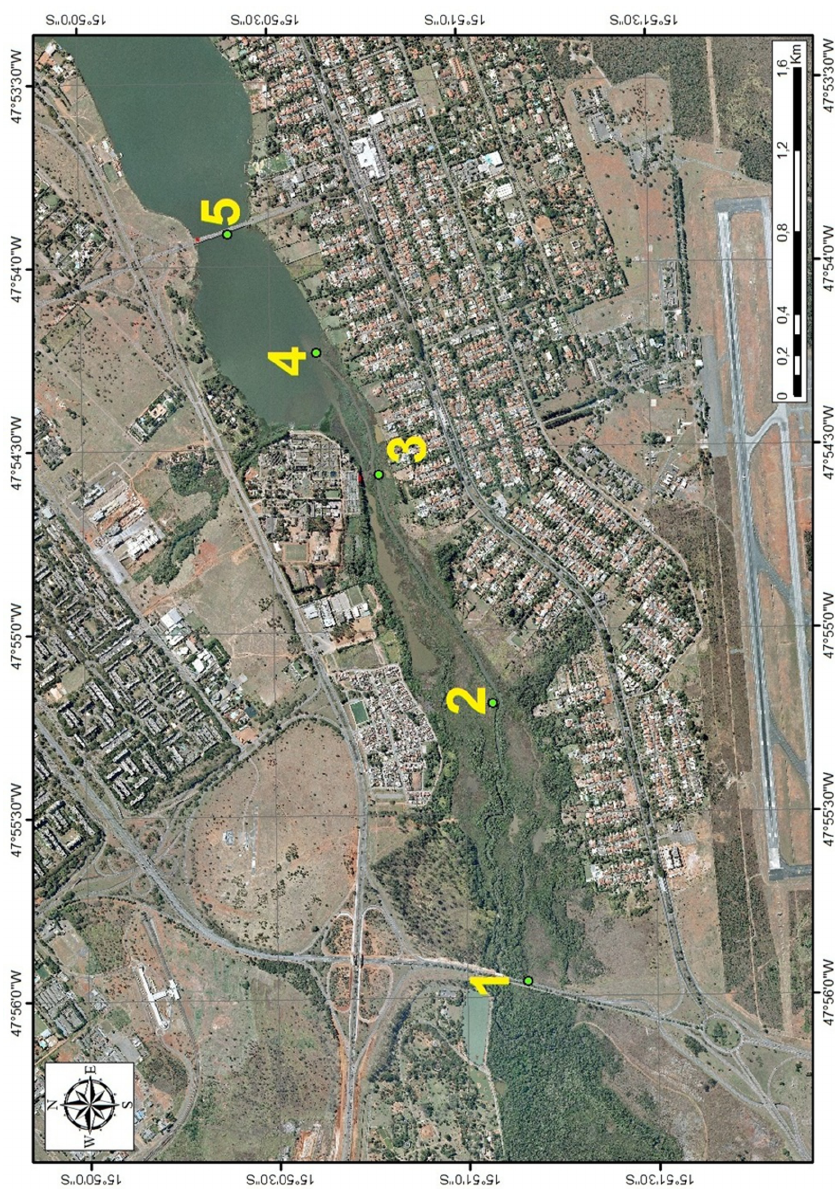
Figure 1. Samples points at Riacho Fundo’s